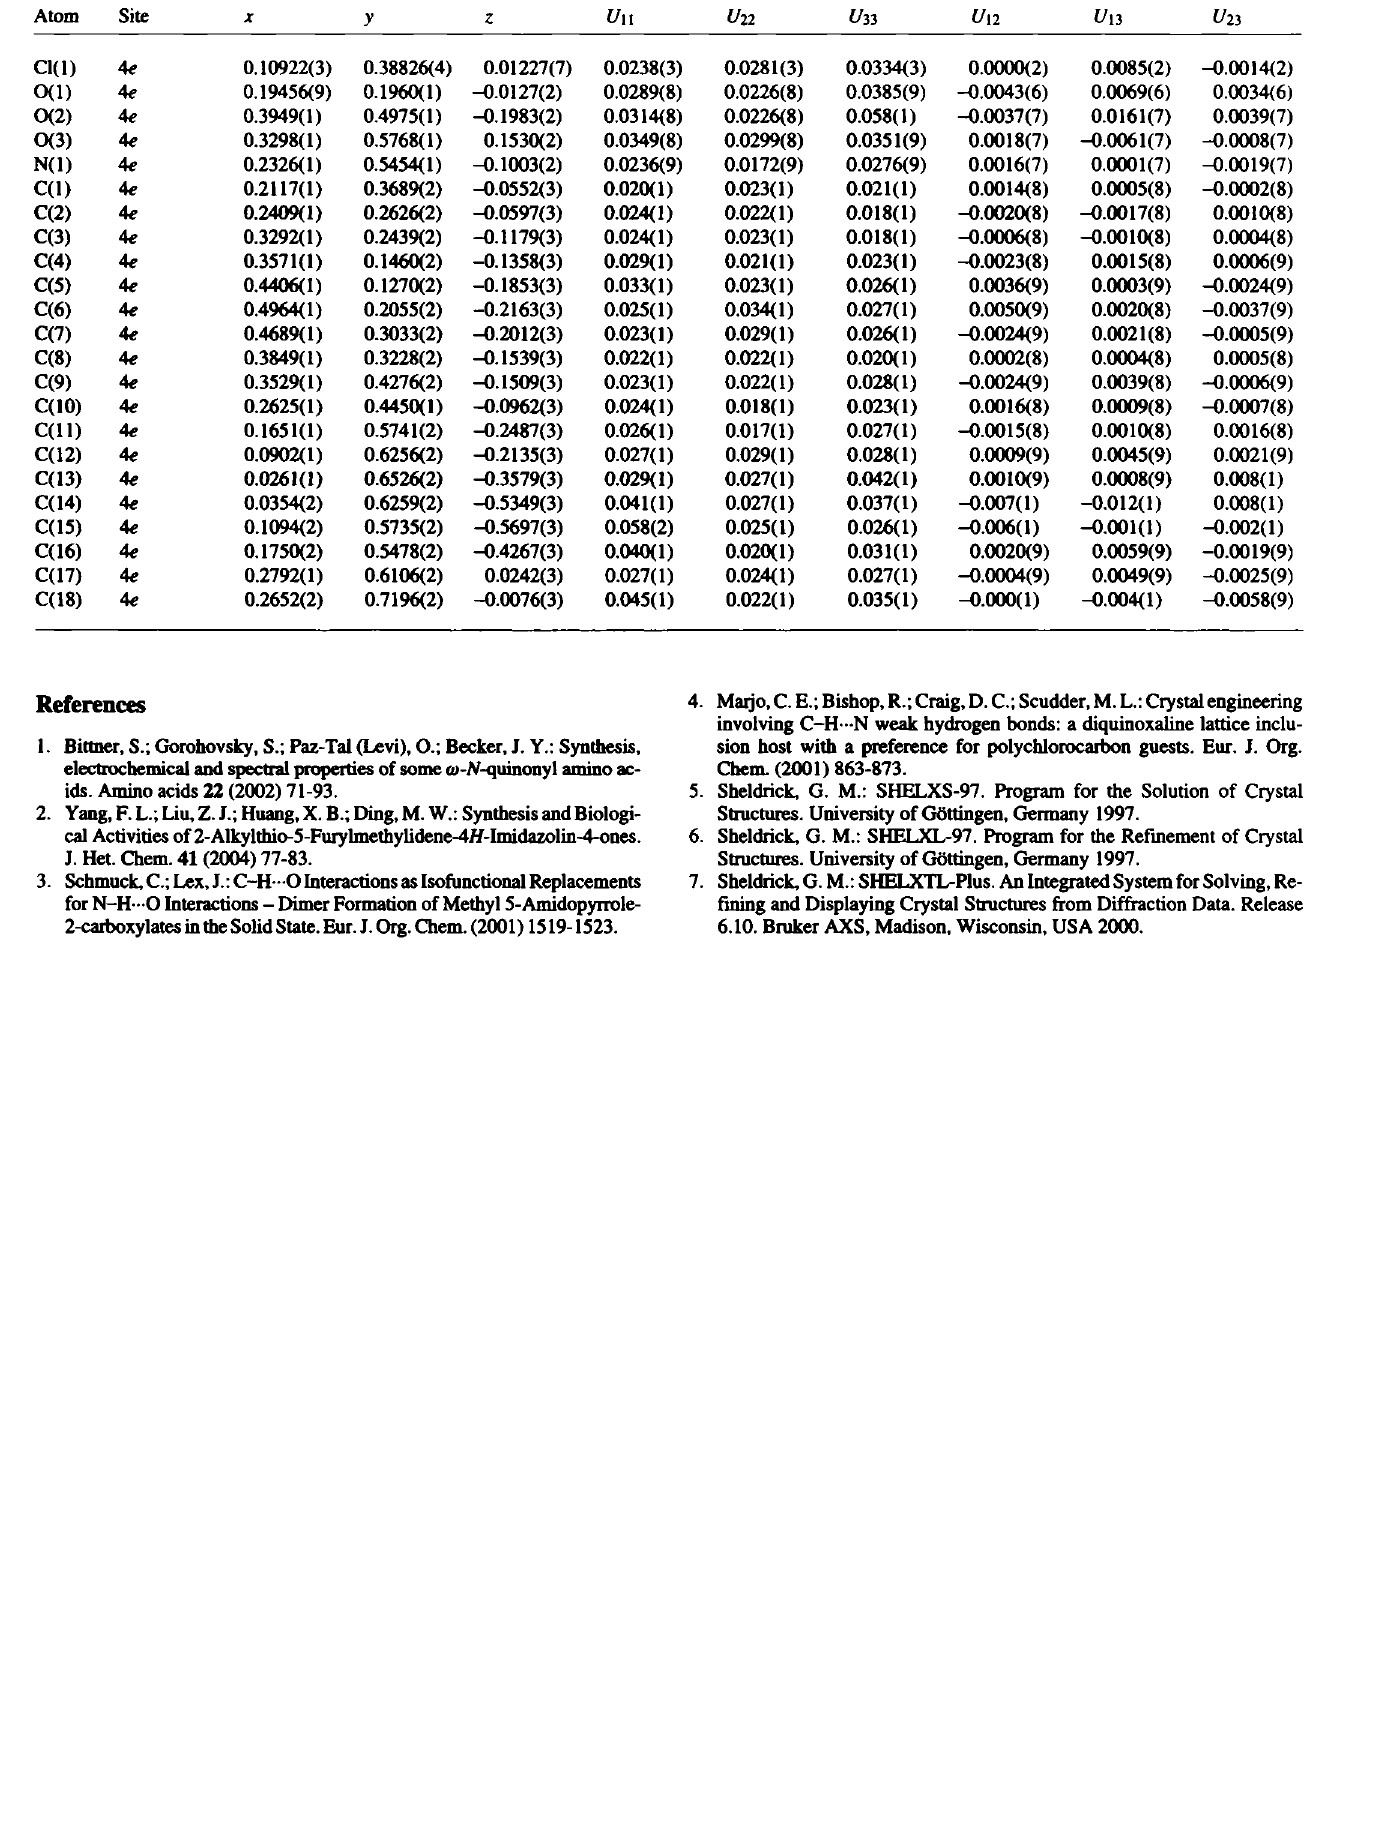
Table 3. Atomic coordinates and displacement parameters (in A 2